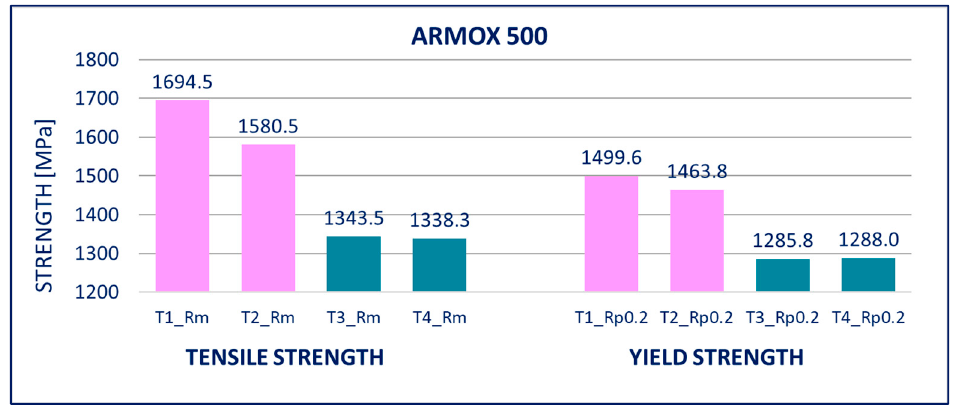
Figure 10. Tensile tests of specimens from ARMOX 500 steel. Description of specimens: T1 and T2 are groups of specimens without zinc coating; T3 and T4 are groups of specimens after hot-dip gal- vanization. R m is tensile strength, R p0.2 is yield strength.